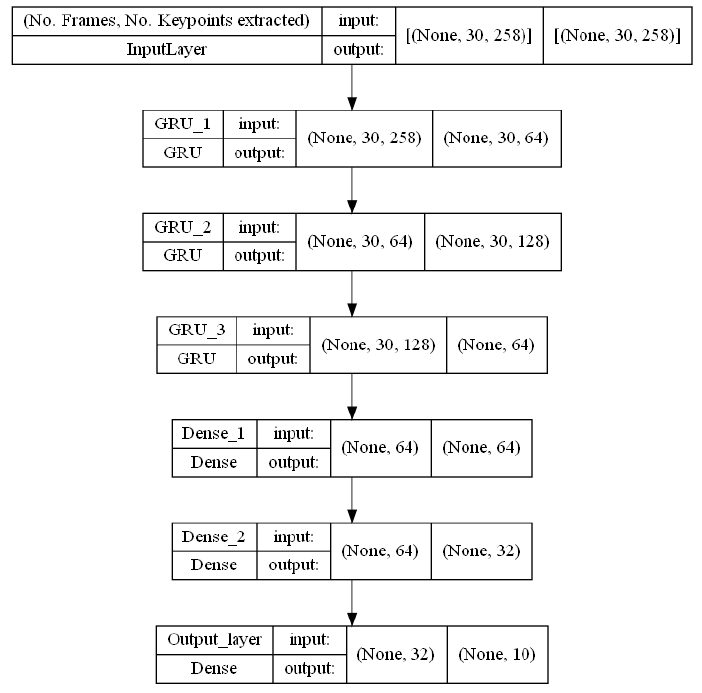
Figure 7. GRU model structure.